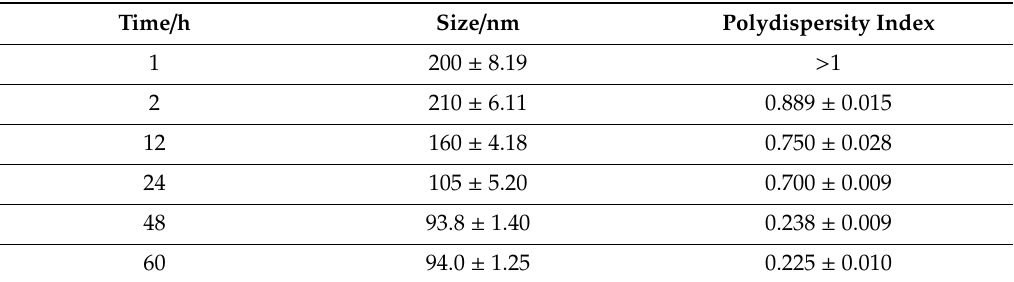
Table 1. Evolution of size and polydispersity index of lipid (L)–oleylamine (OA)–Prussian blue (PB) over time ( n =